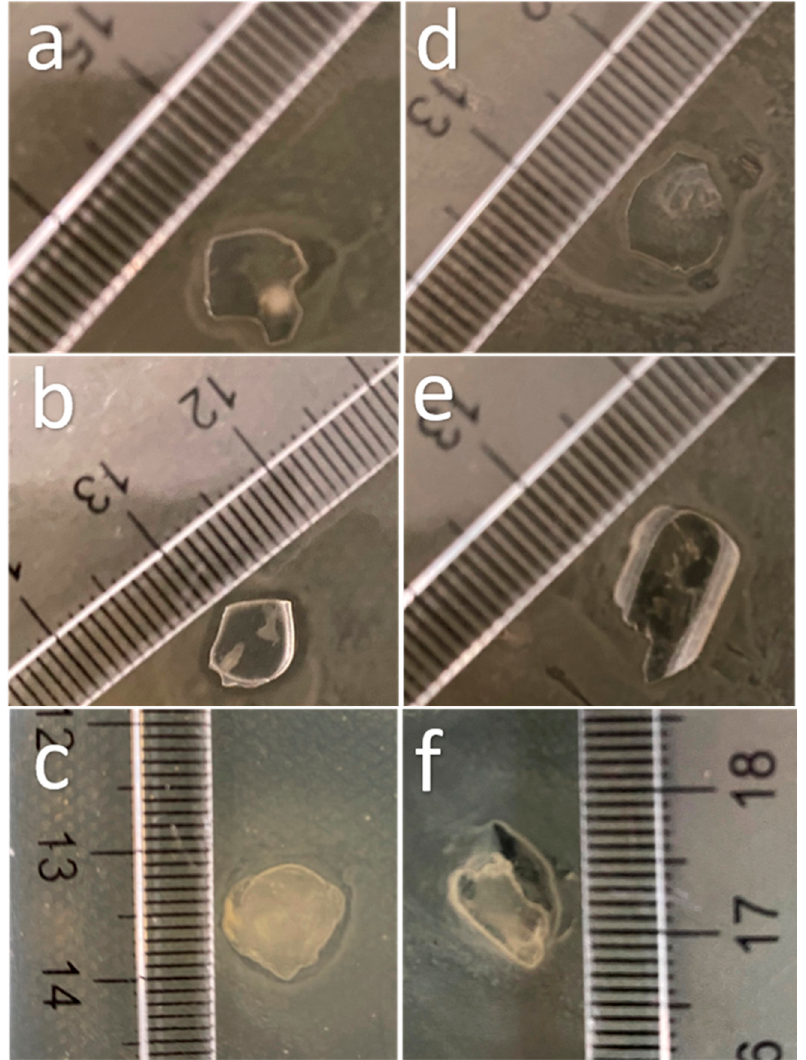
Figure 6. Images of the effect of starch-based films reinforced with chitosan extracted from P. magdalenae scales on E. coli culture ( a ) without chitosan, ( b ) with Chi-commercial and ( c ) with Chi-2%; and on S. aureus culture ( d ) without chitosan, ( e ) with Chi-commercial and ( f ) with Chi-2%.